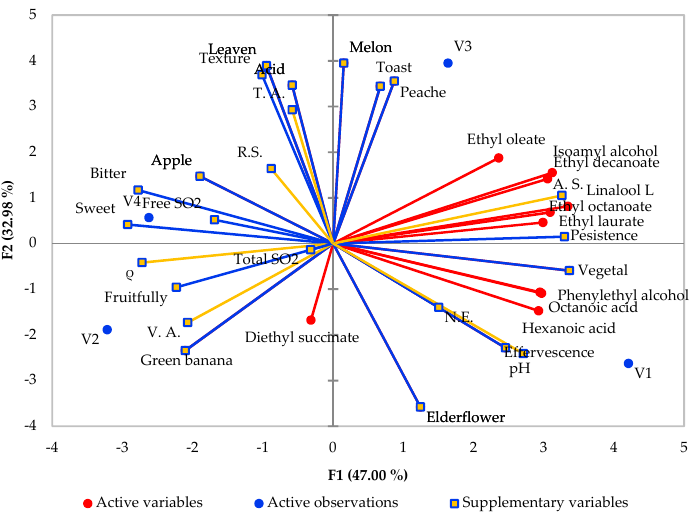
Figure 4. Principal component analysis based on the sensory analysis results, predominating volatile compounds, and wine basic parameters.